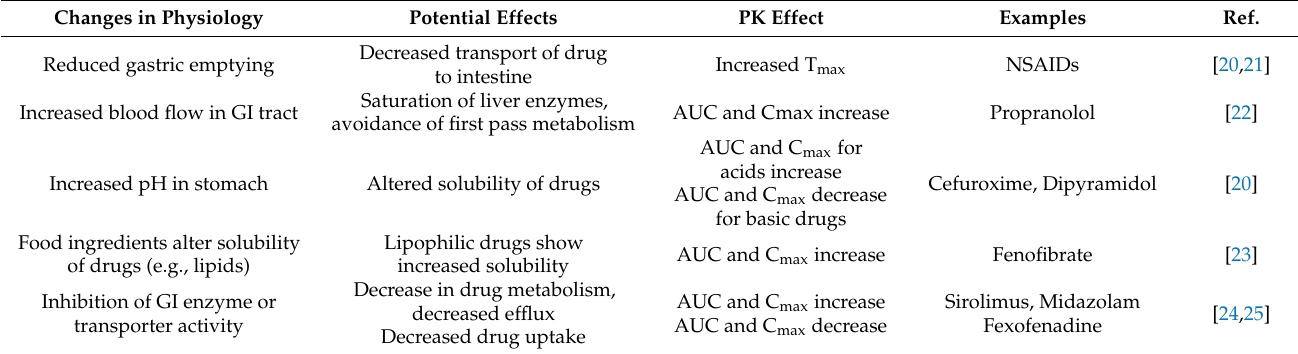
Table 1. Physiological changes induced by food and their effects on